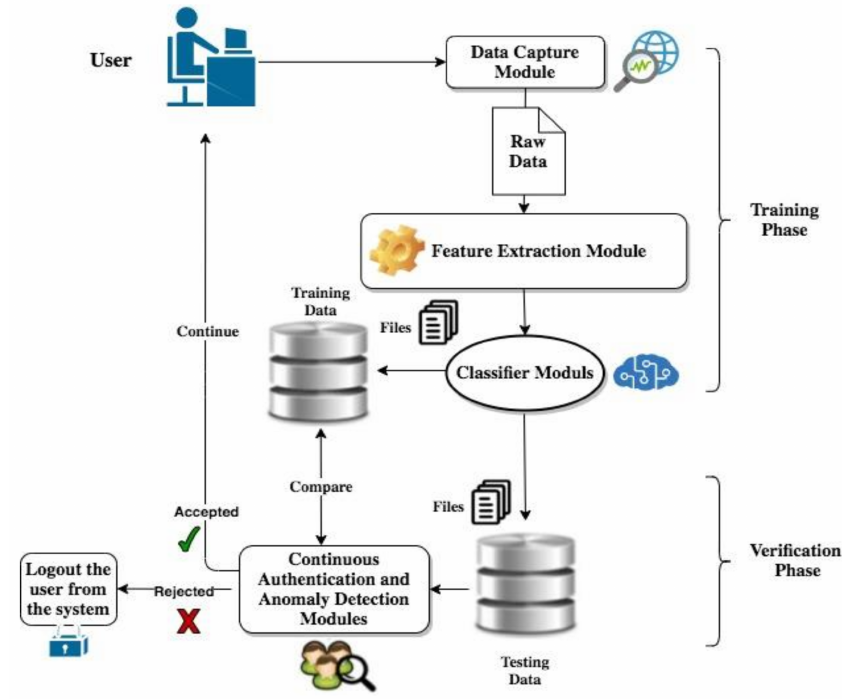
Figure 11. Continuous authentication and anomaly detection